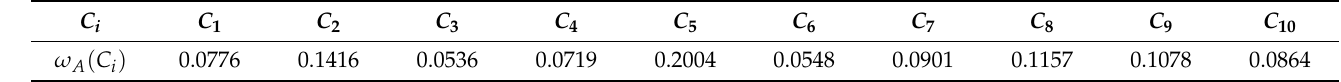
Table 4. Weights of elements in the scheme layer to decision